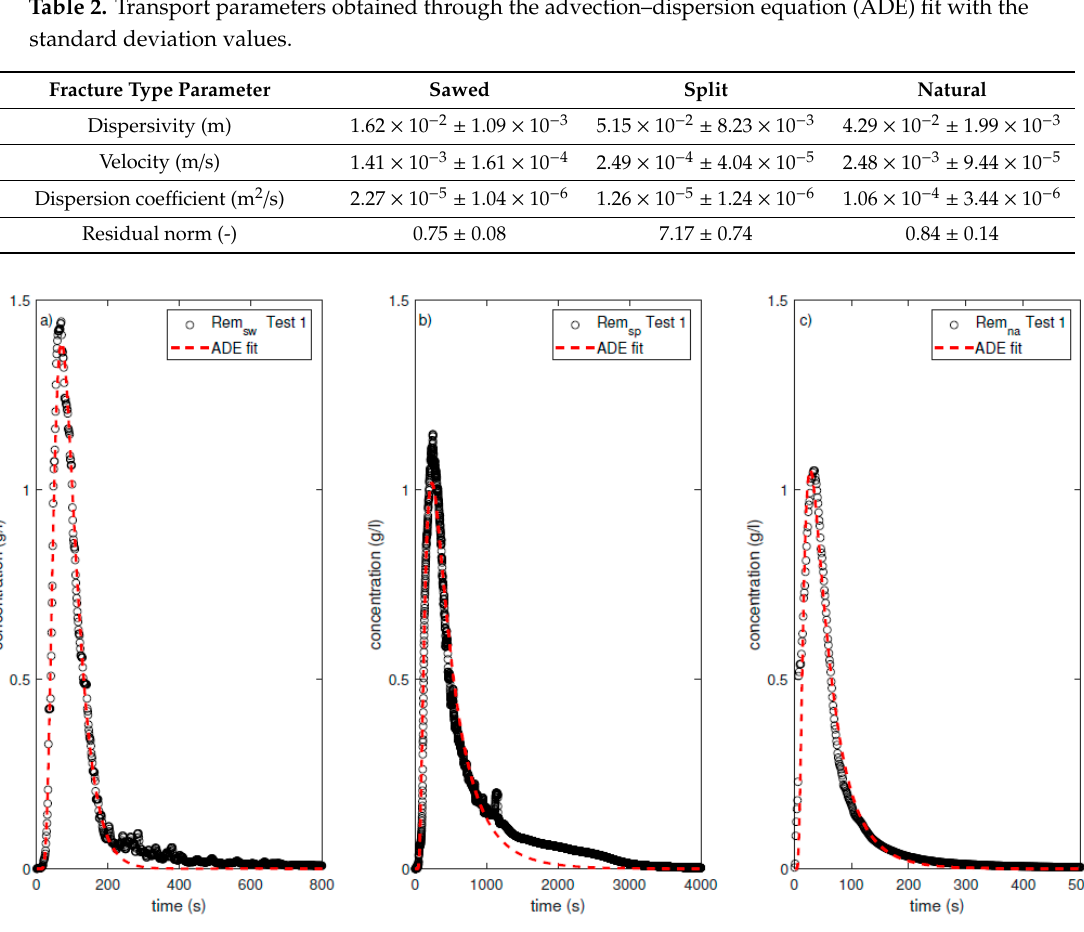
Figure 7. ADE fits for the measured BTCs for the sawed ( a ), split ( b ) and natural fracture ( c ).